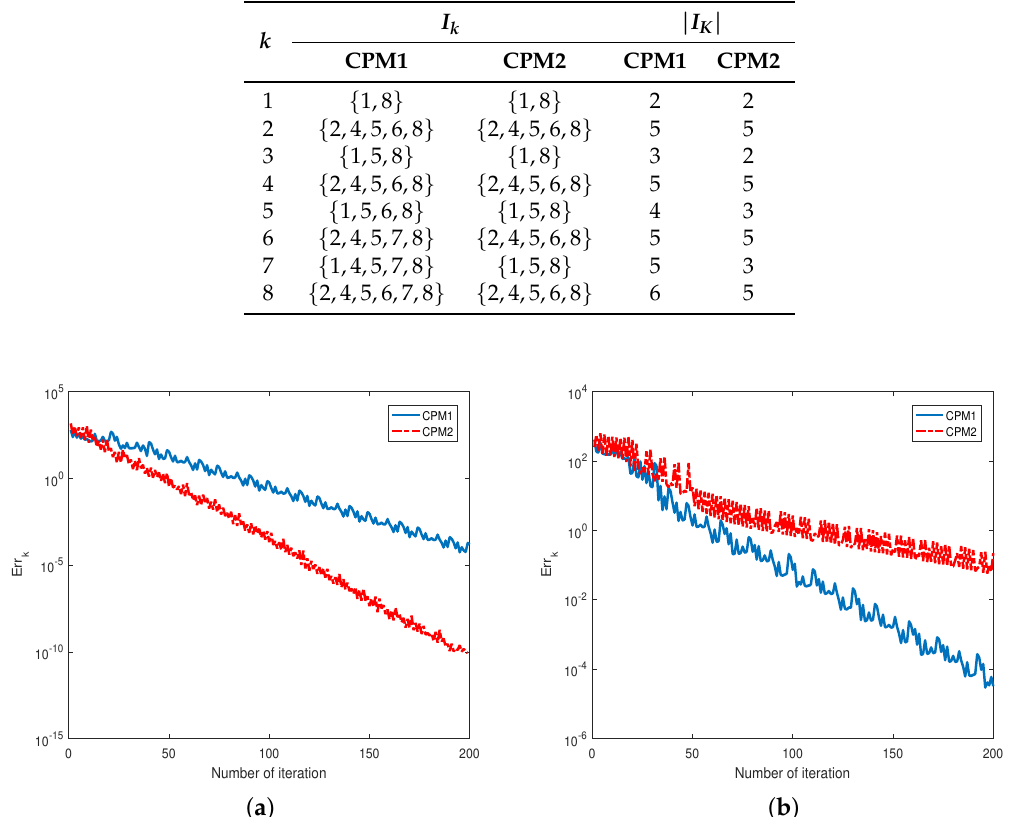
( k ) for different random choices of x 0 for Example 1. ( a ) i